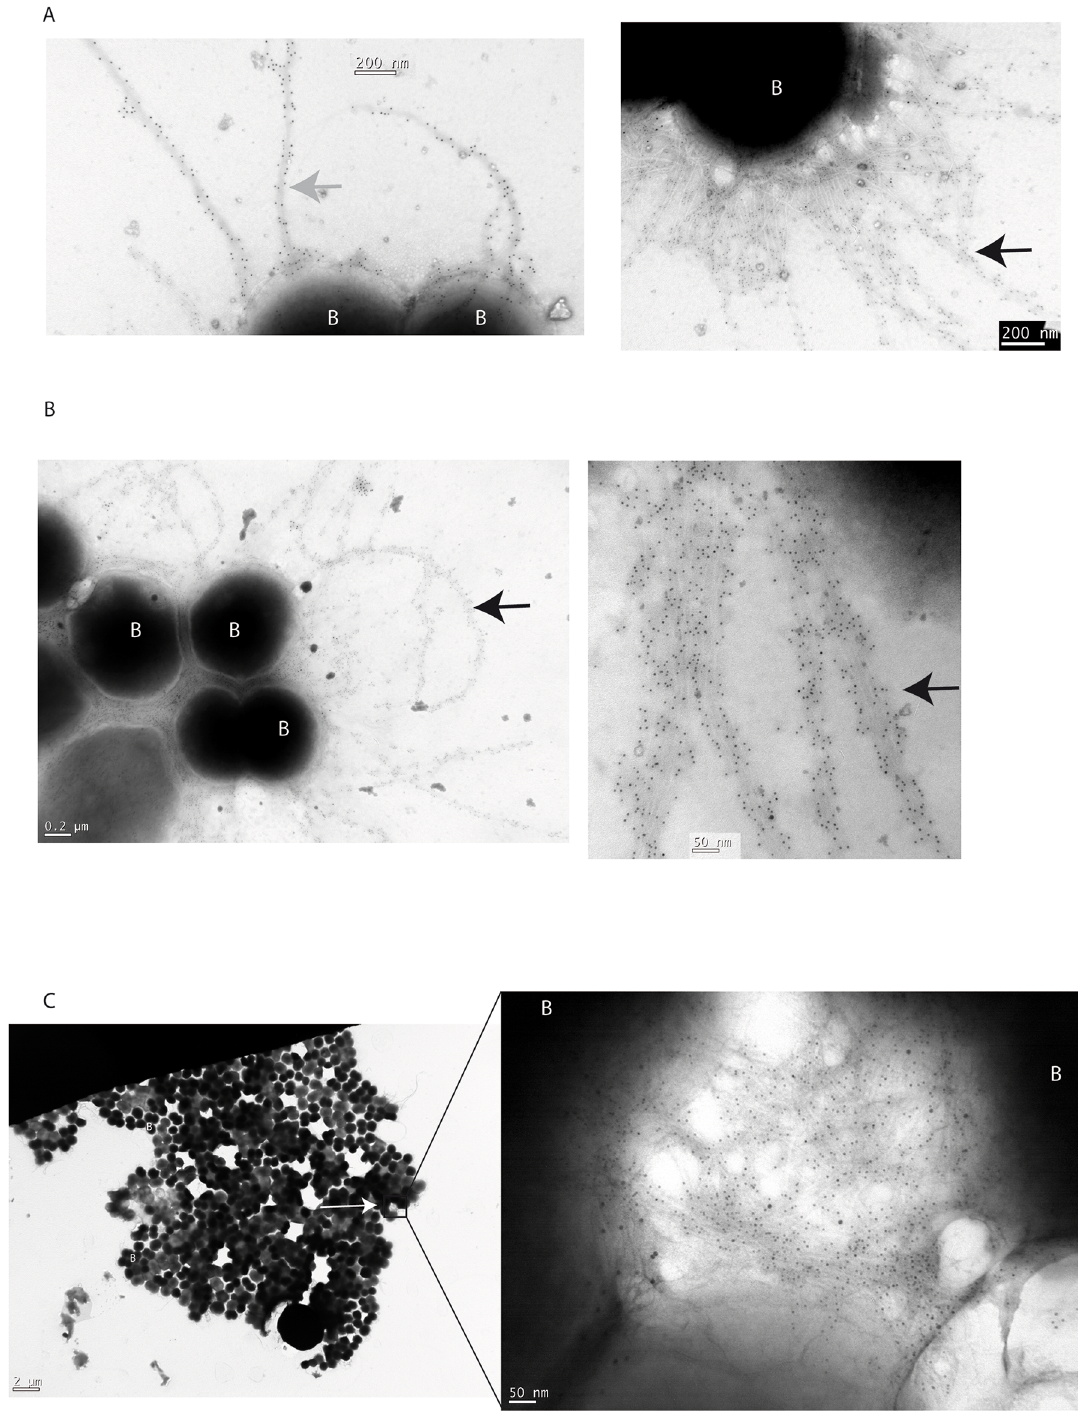
Fig 6. Immunogold-labelling of MDA Φ and type IV pili of material harvestedfrom a flow chamber by aspiration. Two antibodieswere used: (i) the anti-MDAORF4 polyclonal antibody labelledwith 8 nm-diameter gold particlesand (ii) the monoclonal antibody20D9 directedagainst the SB pilin variant and labelledwith 12 nm-diameter gold particles. (A) Positive control, strain Z5463(SB- aph3’ )grown under standardconditions. Left panel, bacteriaare labelledby 12 nm beads corresponding to pili, the gray arrow points toward 12 nm beads. Right panel, bacteria surroundedonly by filaments labelledby small particles corresponding to filamentous bacteriophages,the black arrow points toward 8 nm beads. (B) Material harvestedfrom the biomass covering a monolayerof FaDu cells infected by Z5463(SB- aph3’ )and labelledby the abovetwo